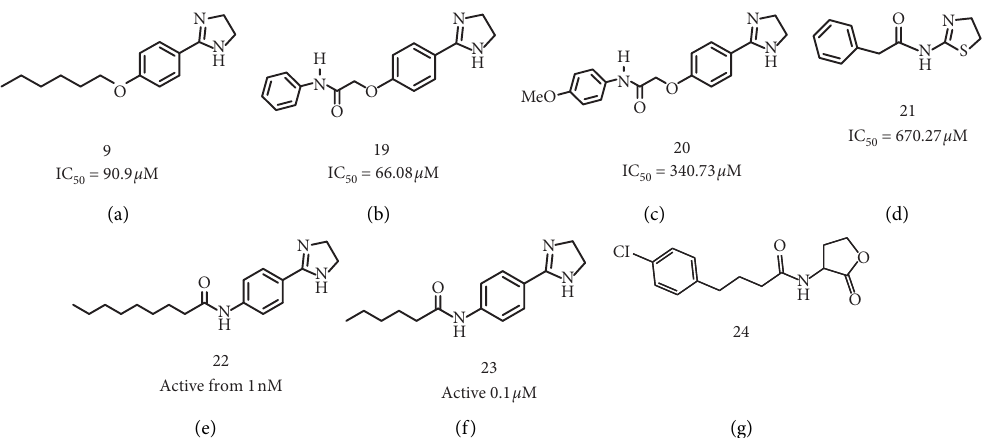
Figure 4: IC 50 of some azolines [12, 14] and chlorophenoxy-N-butanoyl homoserine lactone 24 [19] evaluated as QSIs in Chromobacterium violaceum CV026. ND � not